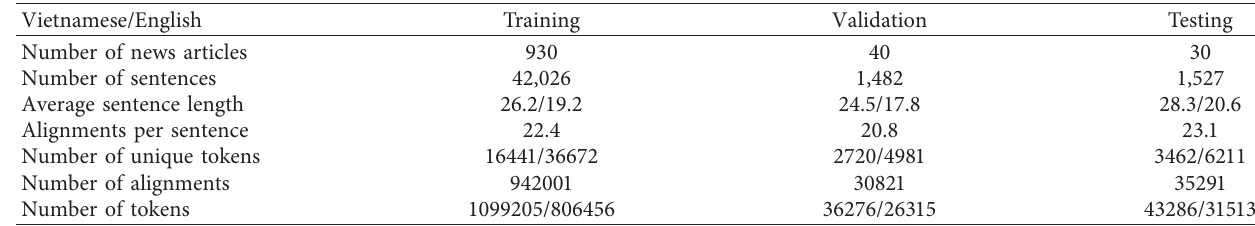
Table 3: Overview of the datasets.